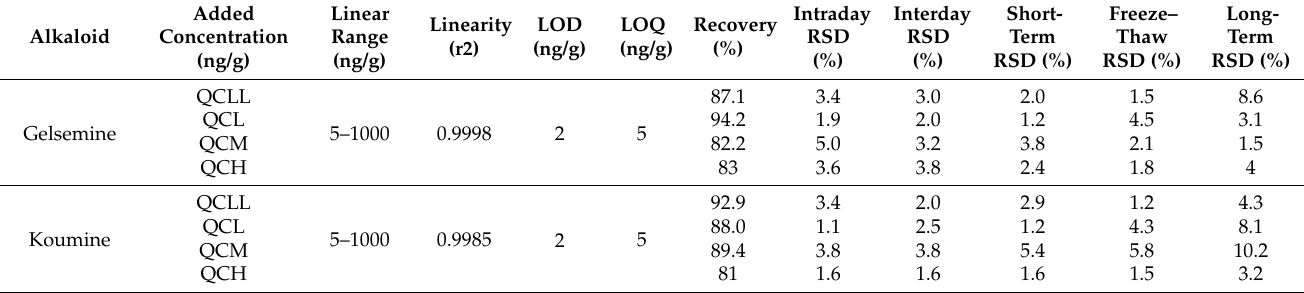
Table 2. Results of linear range, correlation coefficient, LOD, recovery, accuracy, precision and sample